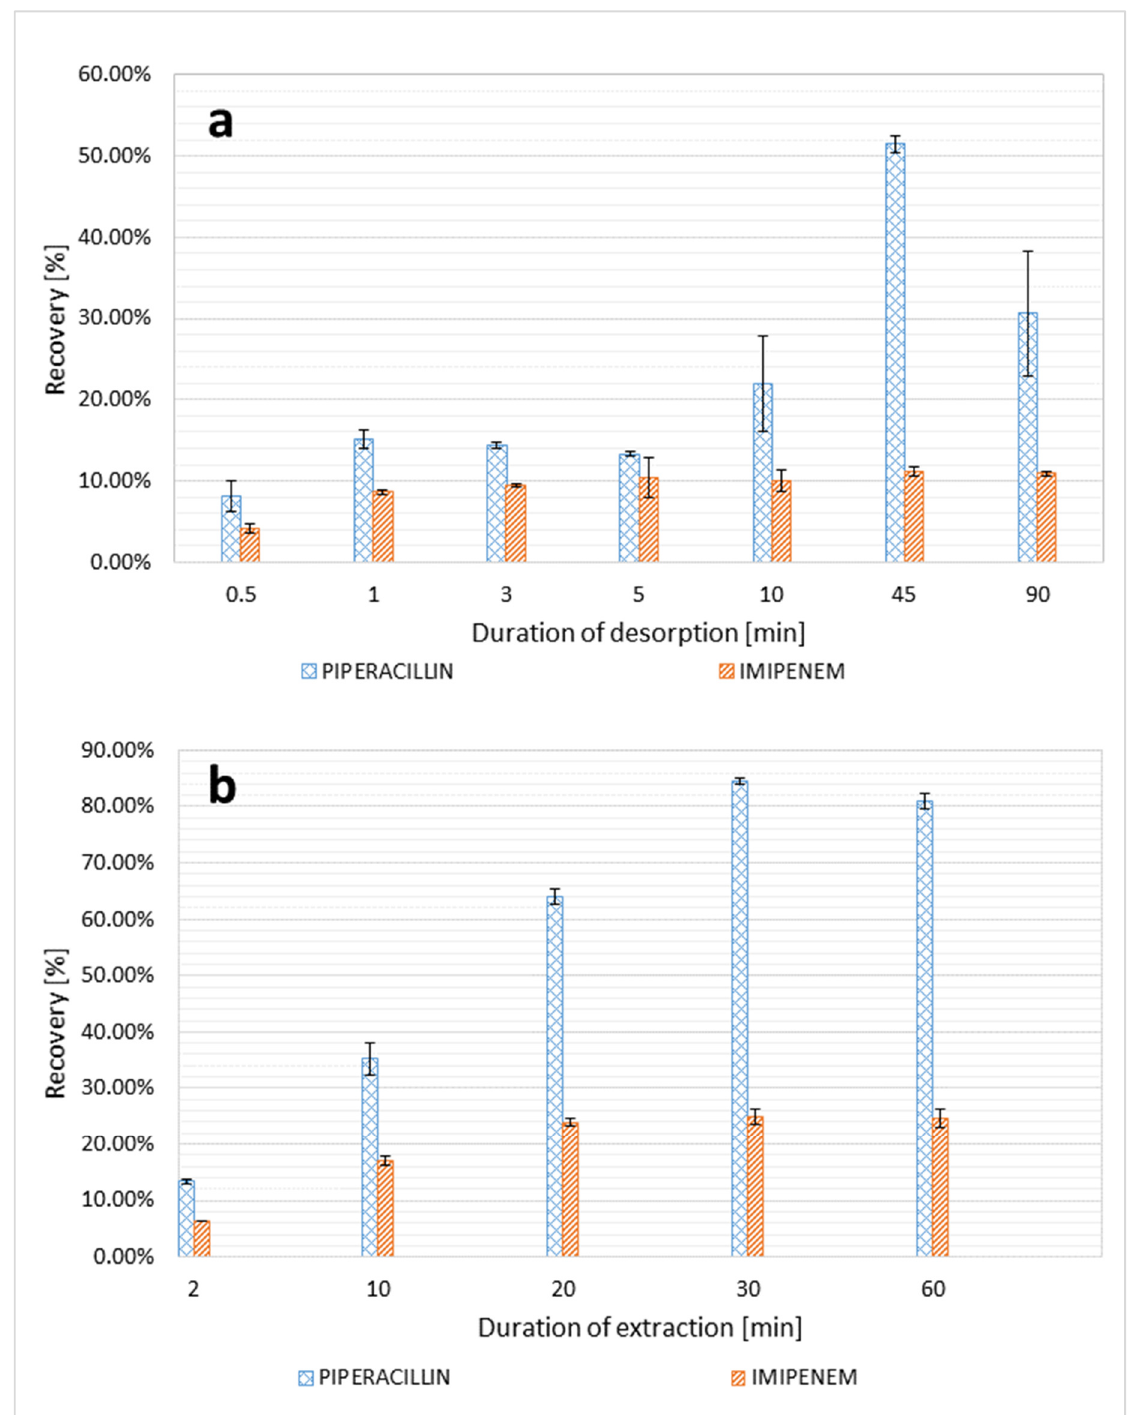
Figure 3. Recovery of piperacillin and imipenem for different durations of desorption ( a ) and extraction ( b ).